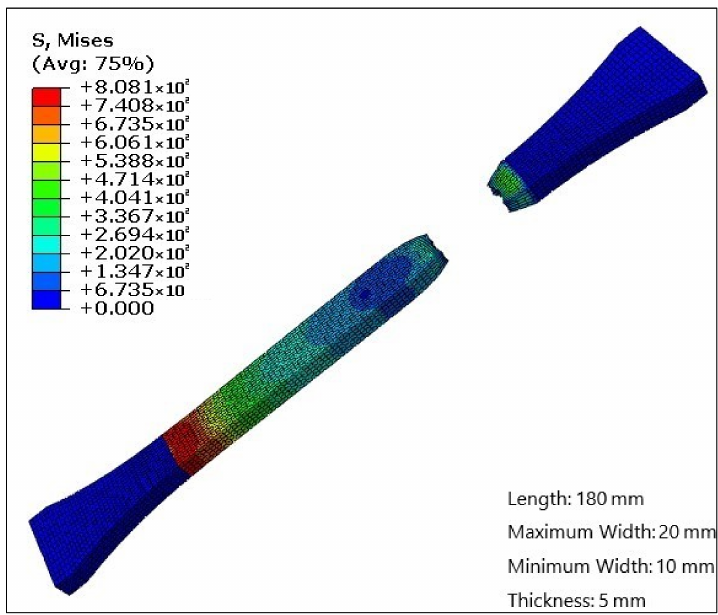
Figure 9. FE simulated tensile fracture damage of AlFeSi phase.